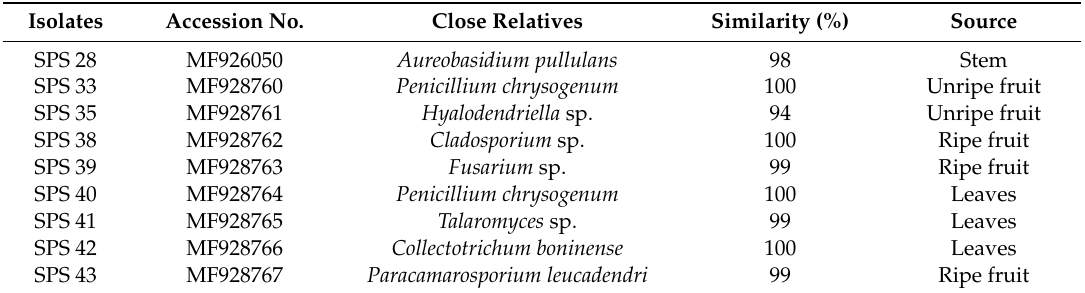
Table 2. List of fungal taxonomic units identified using the molecular identification.